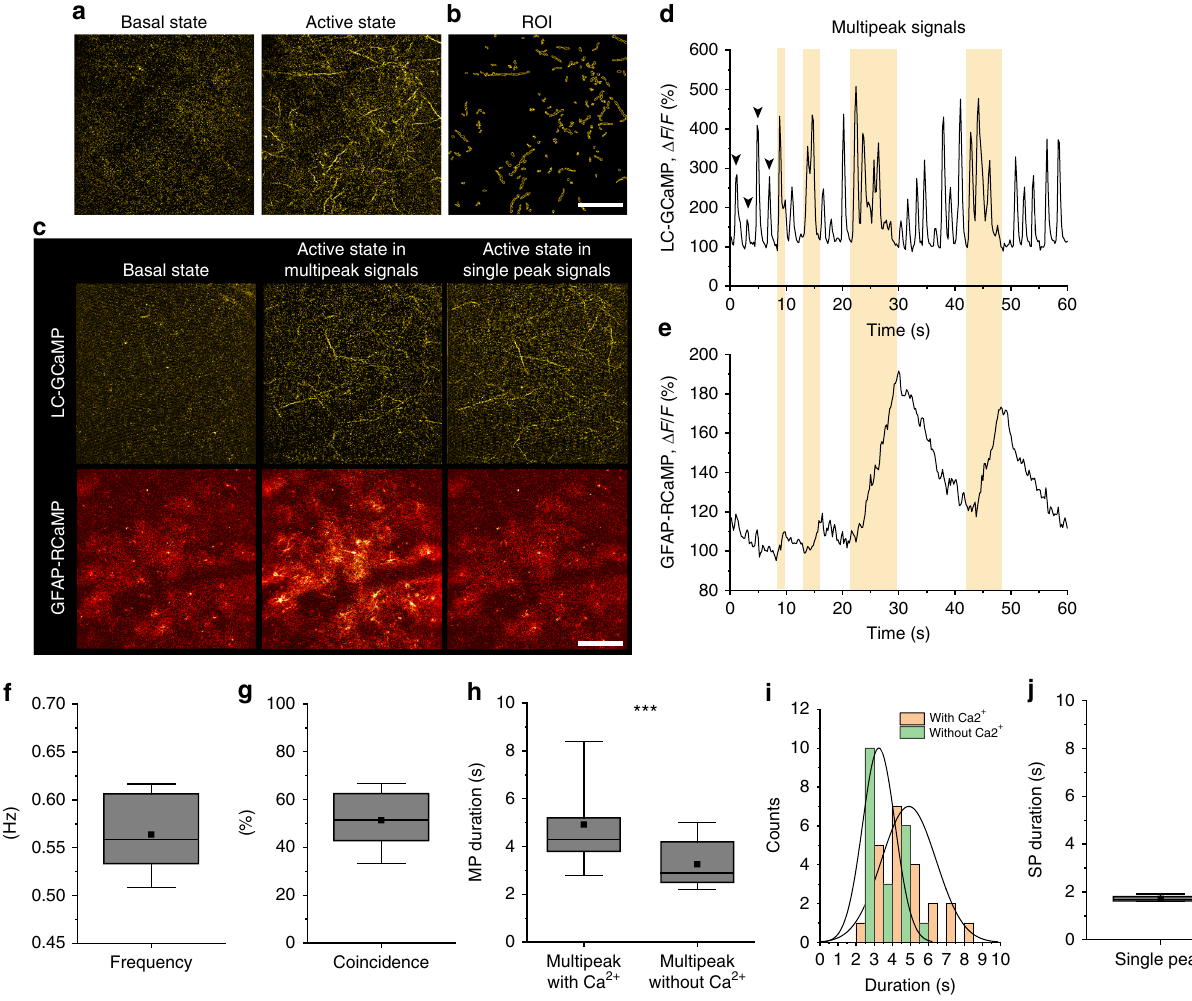
Fig. 4 Astrocytic Ca 2 + signals are accompanied by NAergic multipeak signals in awake spontaneous states. a , b Representative images of a basal state and an active state of NAergic fi bers ’ Ca 2 + levels visualized by GCaMP6.f ( a ) and ROIs ( b ). Scale bar: 100 μ m. c Representative pictures of LC-GCaMP and GFAP-RCaMP. Note that the GFAP-RCaMP images were acquired with a 5-s delay from the respective LC-GCaMP images. Only active states with MP signals accompany astrocytic Ca 2 + elevation. Scale bar: 100 μ m. d , e One minute simultaneous recording of LC-GCaMP and GFAP-RCaMP. NAergic signals are composed of SP signals (arrowhead) and MP signals (yellow period) ( d ). Astrocytic Ca 2 + is correlated with NAergic MP signals ( e ). f Frequency of combined single and MP events. Individual MP signals were counted as single events ( n = 1276 s recording, fi ve mice for all analyses). g Coincidence of astrocytic Ca 2 + with NAergic MP signals. h , i Durations of divided multipeak signals testing whether they accompany astrocytic Ca 2 + are plotted in box plot ( h ) and histogram ( i ). j Durations of SP signals. Analysis was performed from individual SP or MP signals. Box plots: box